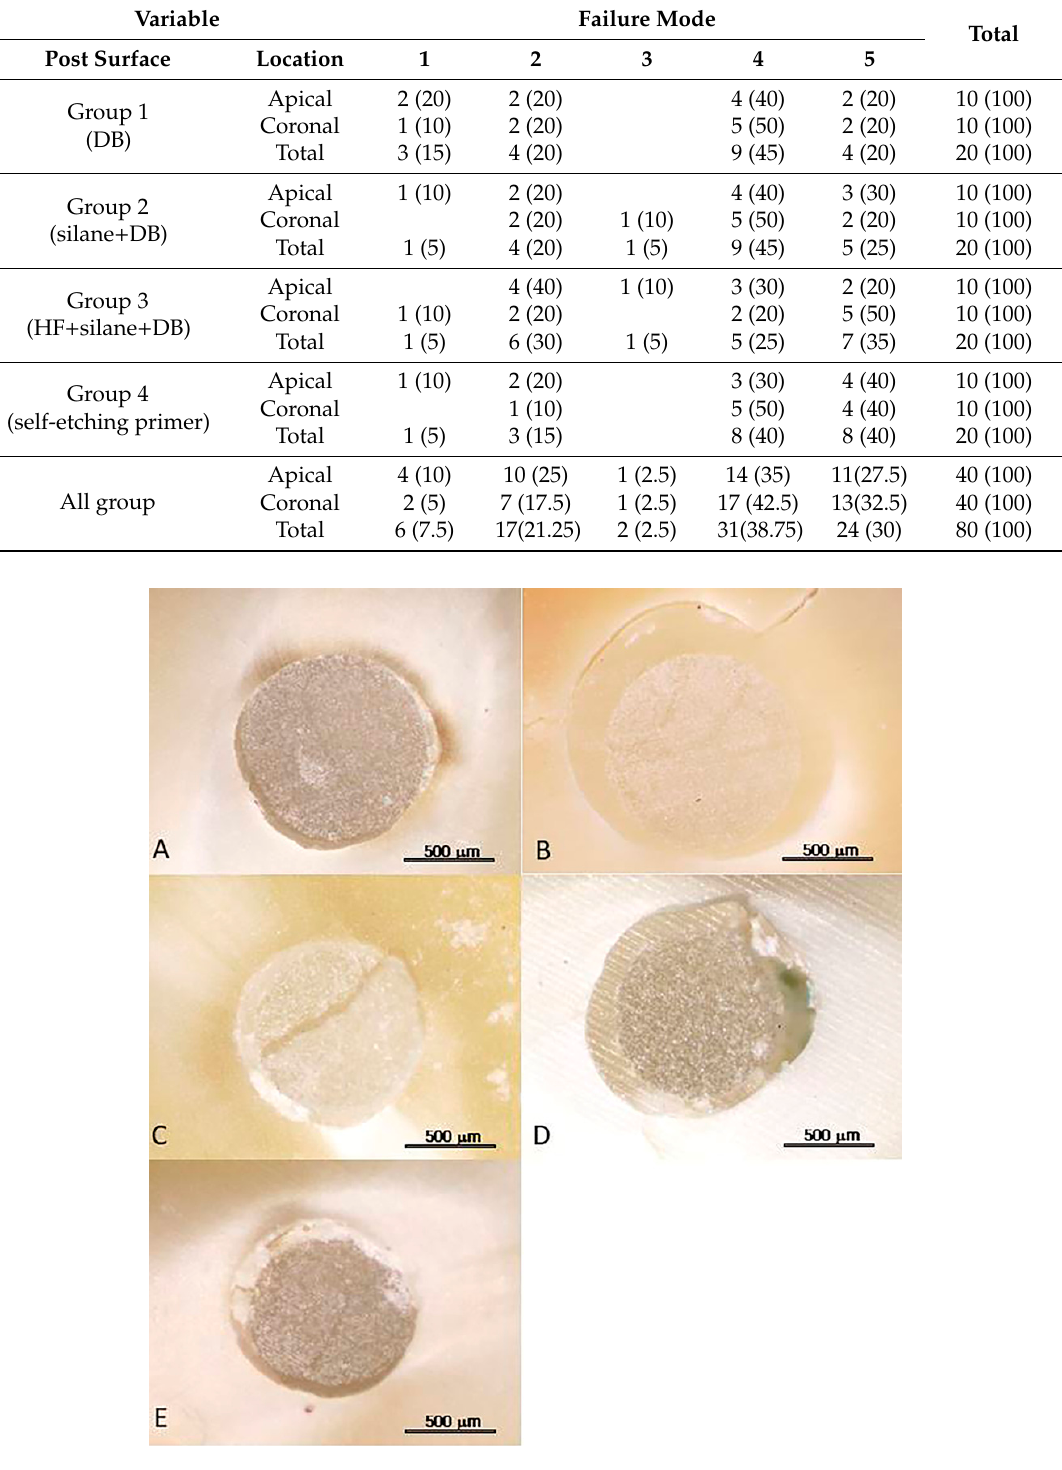
Figure 3. Microscopic views of failed specimens: ( A ) adhesive failure between the luting material and post; ( B ) adhesive failure between luting material and dentin; ( C ) cohesive failure of FRCP; ( D ) cohesive failure of luting material; ( E ) mixed type fracture.